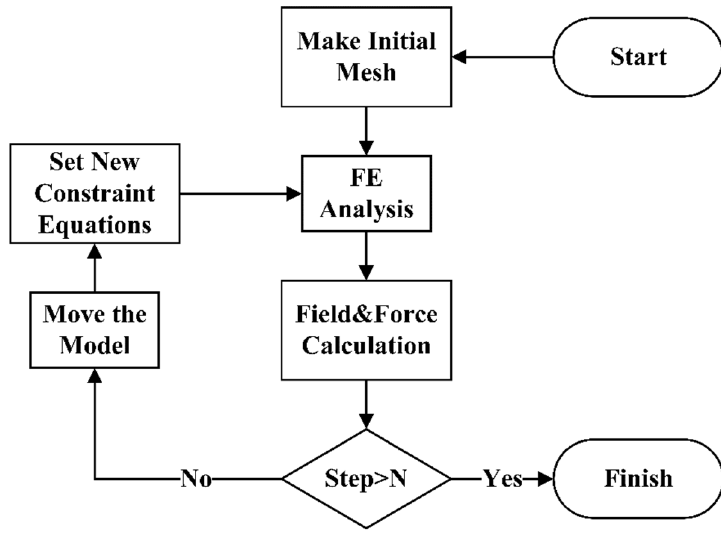
Figure 3. Finite element analysis flow chart.